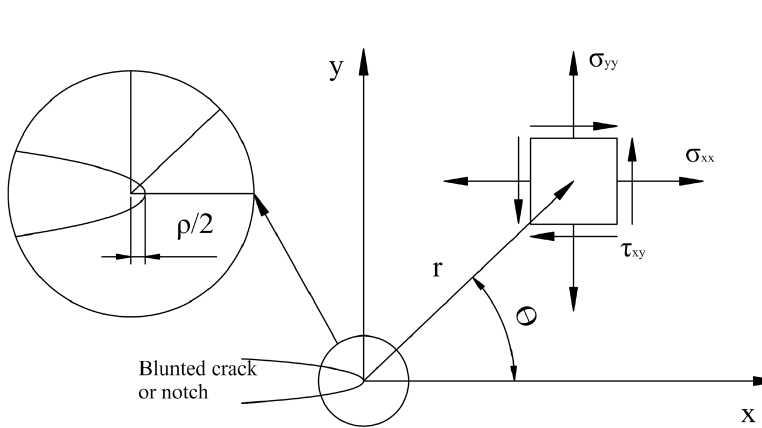
Figure 1. Coordinate system considered by Creager and Paris 18